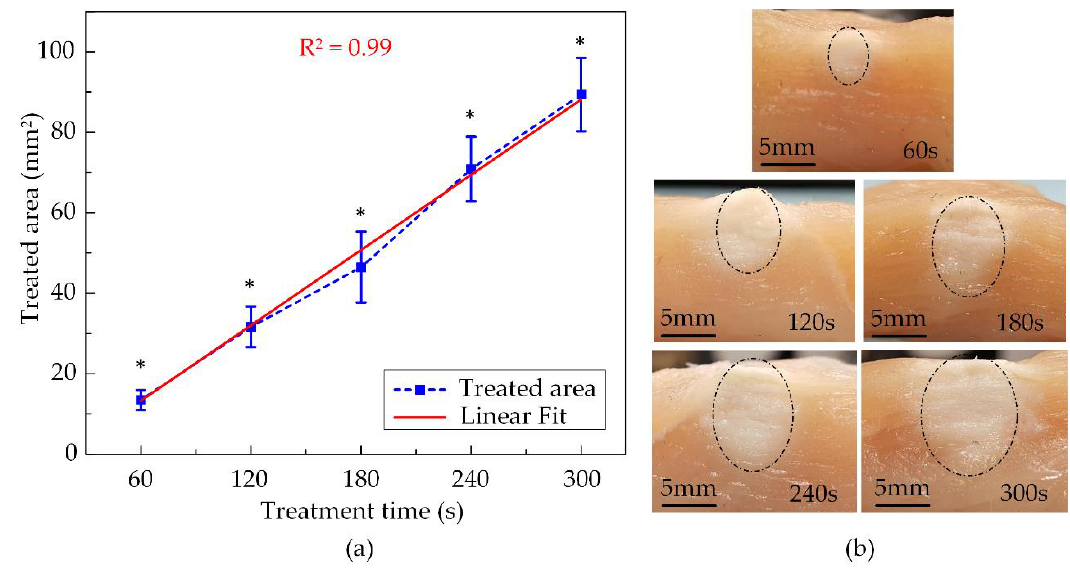
Figure 9. The ex vivo experiment’s results using fuzzy logic control at various exposure times: ( a ) Treated areas (N = 5) ( b ) The cross-sectional images of treated tissues (* indicate significant difference at p < 0.05).